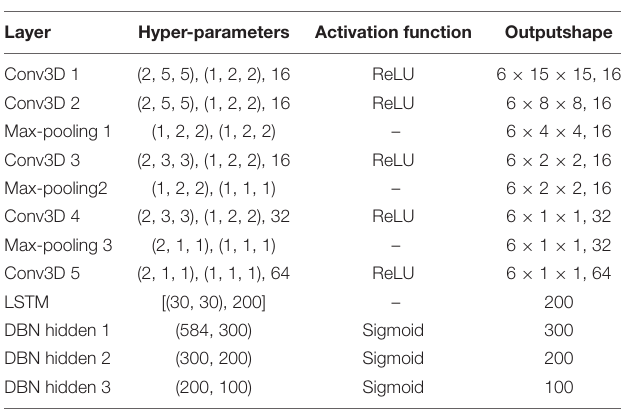
TABLE 2 | The parameters of proposed model.